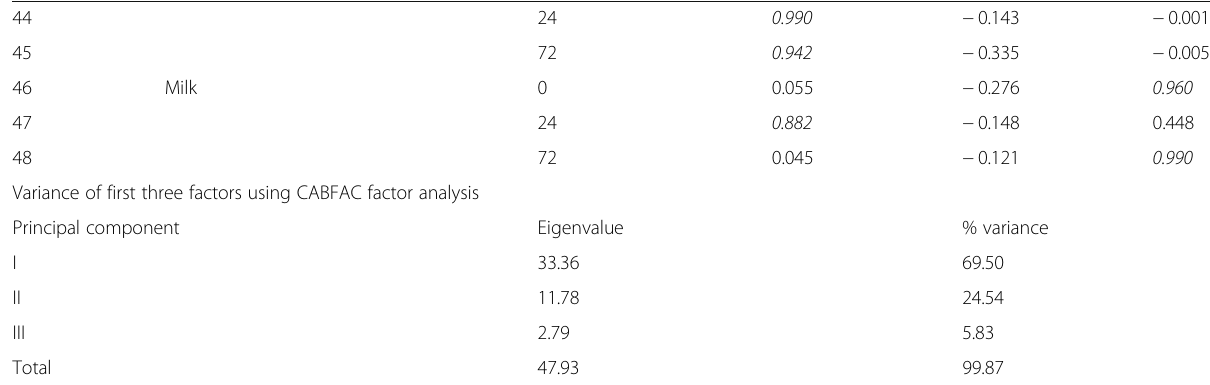
Table 2 CABFAC factor analysis of edible food plants and milk on the basis of organic acid contents for 0 h, 24 h, and 72 h under E. coli treatments. Values in italics represent significant factor (Continued)